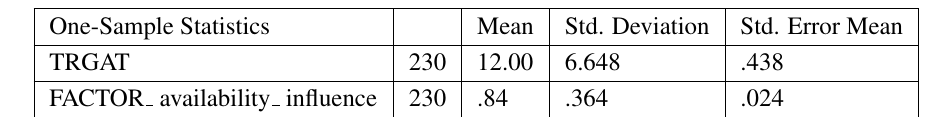
Table 1. T-One-Sample Test- degree ofagreement between the responses of the sample on the importance of the effectof the main variables